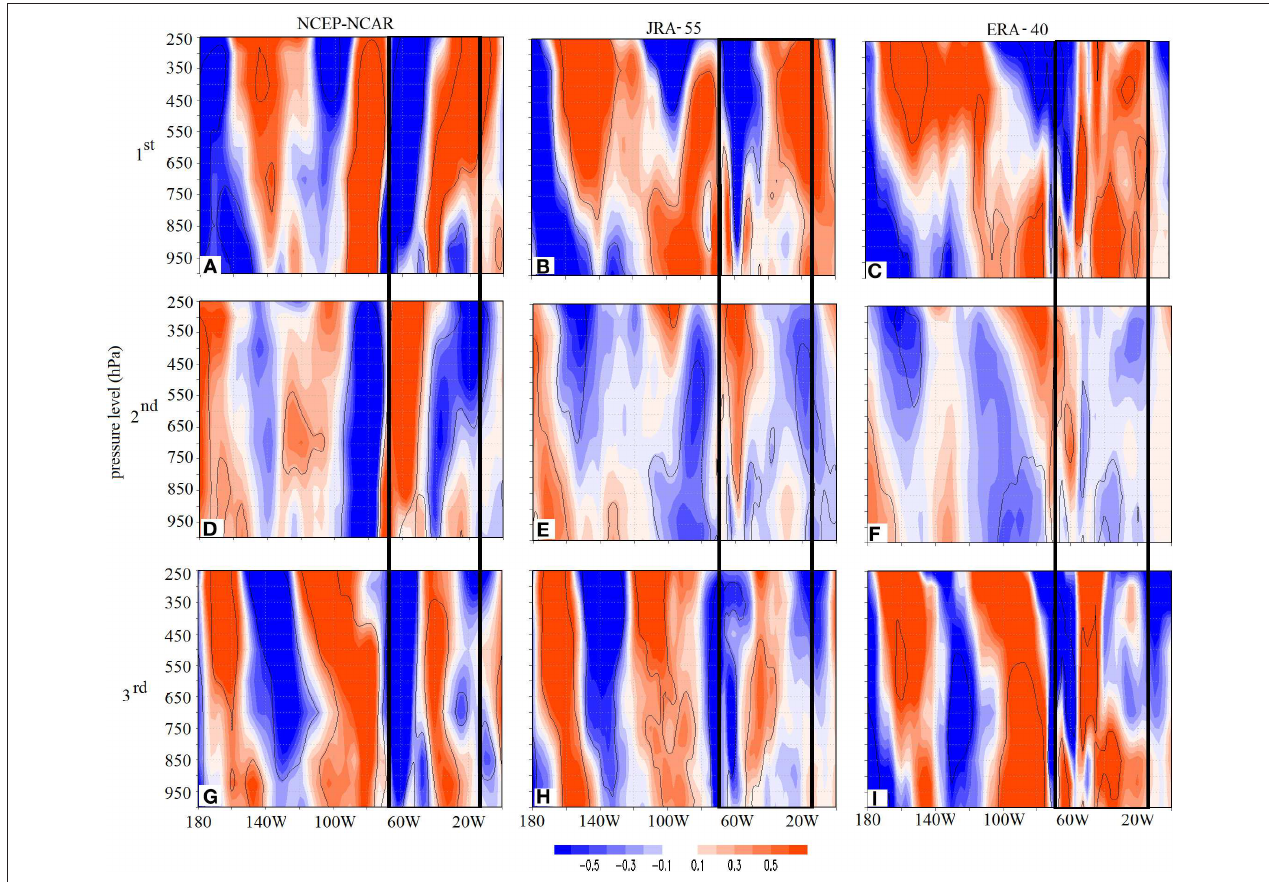
FIGURE 2 | Vertical profile of meridional wind component anomaly (m s − 1 ) averaged between 25 ◦ S and 22 ◦ S for the (A) 1st (1970–1976), (B) 2nd (1977–1996), and (C) 3rd (1997–2001) subperiods for NCEP-NCAR (A,D,G) , JRA-55 (B,E,H) , and ERA-40 (C,F,I) reanalysis. Statistically significant values for α = 0.05 ( t -Student) are surrounded by dotted isolines. The black rectangle includes the southeastern South America